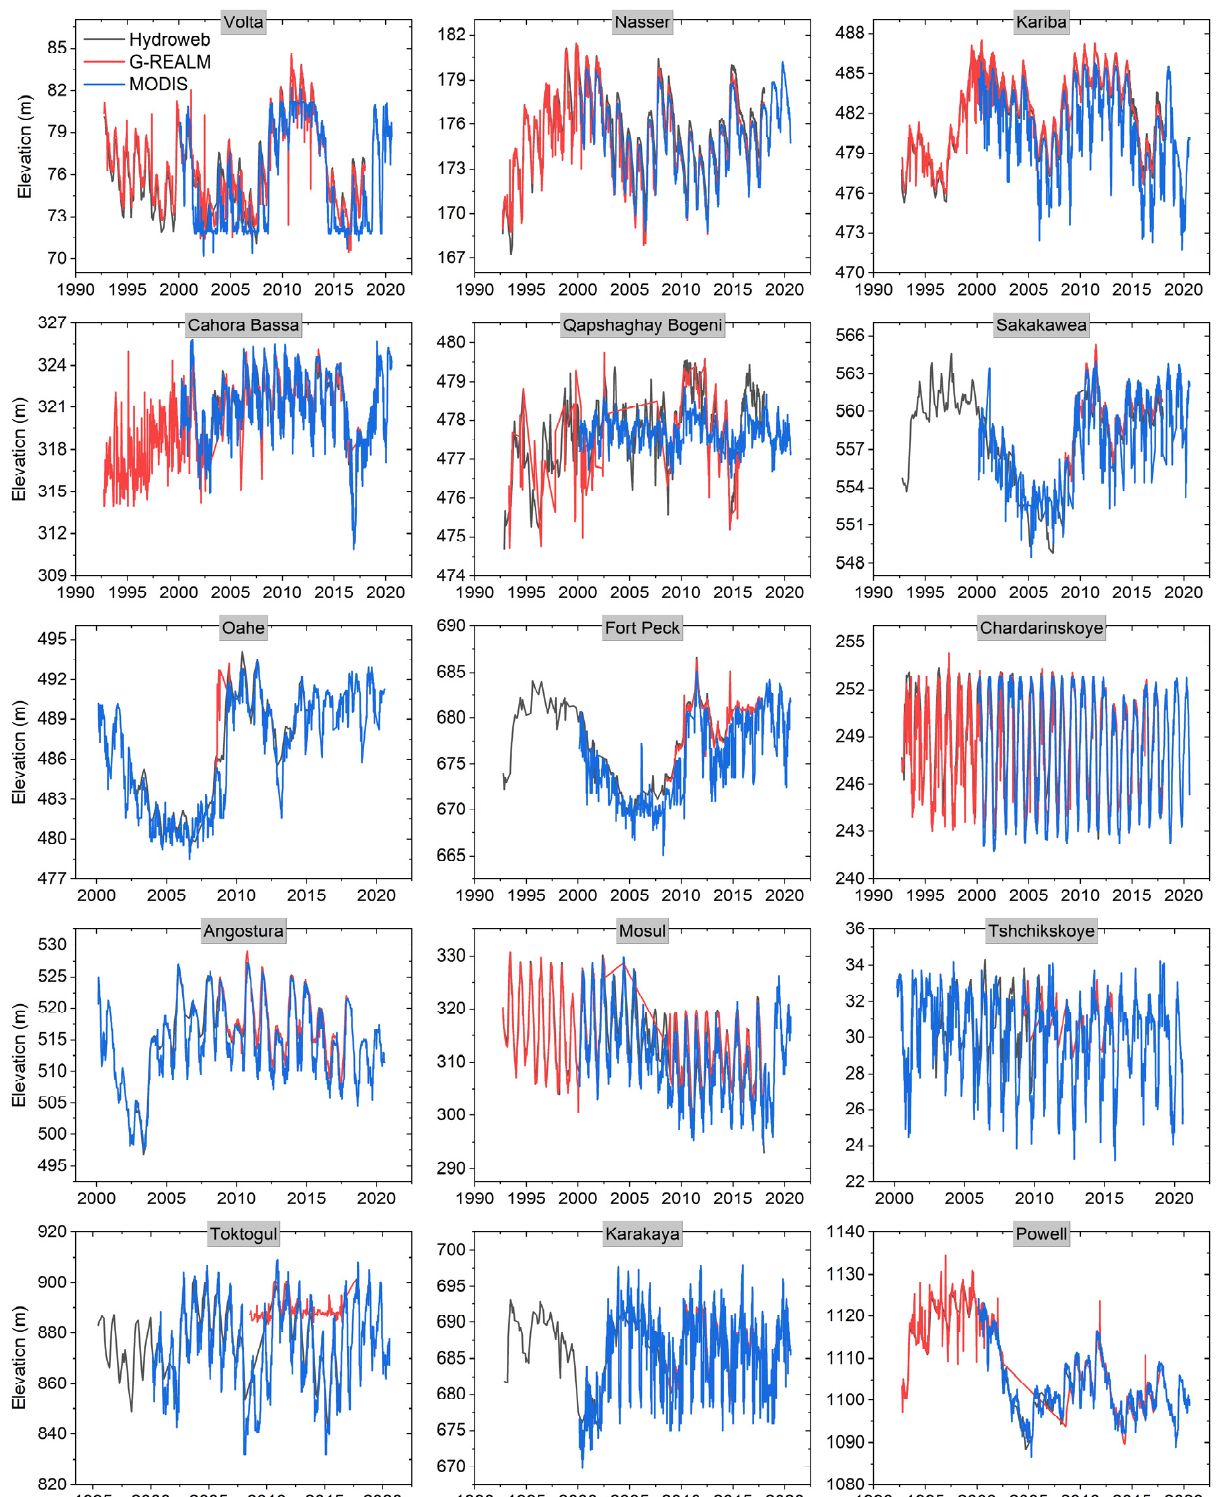
Figure 12. Comparison of elevation time series values between radar altimetry products (Hydroweb and G-REALM) and the MODIS-based product. Note that the elevation measurements provided by G-REALM are not available between 2002 and 2008 for the Qapshaghay Bogeni, Mosul, and Powell reservoirs due to a data gap. These are filled in by linear interpolation. rate and surface area uncertainties, which have been discussed